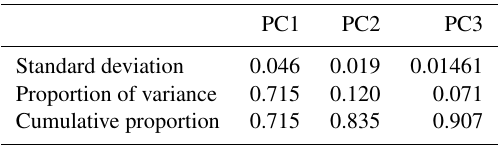
Table 1. Importance of the first three principal